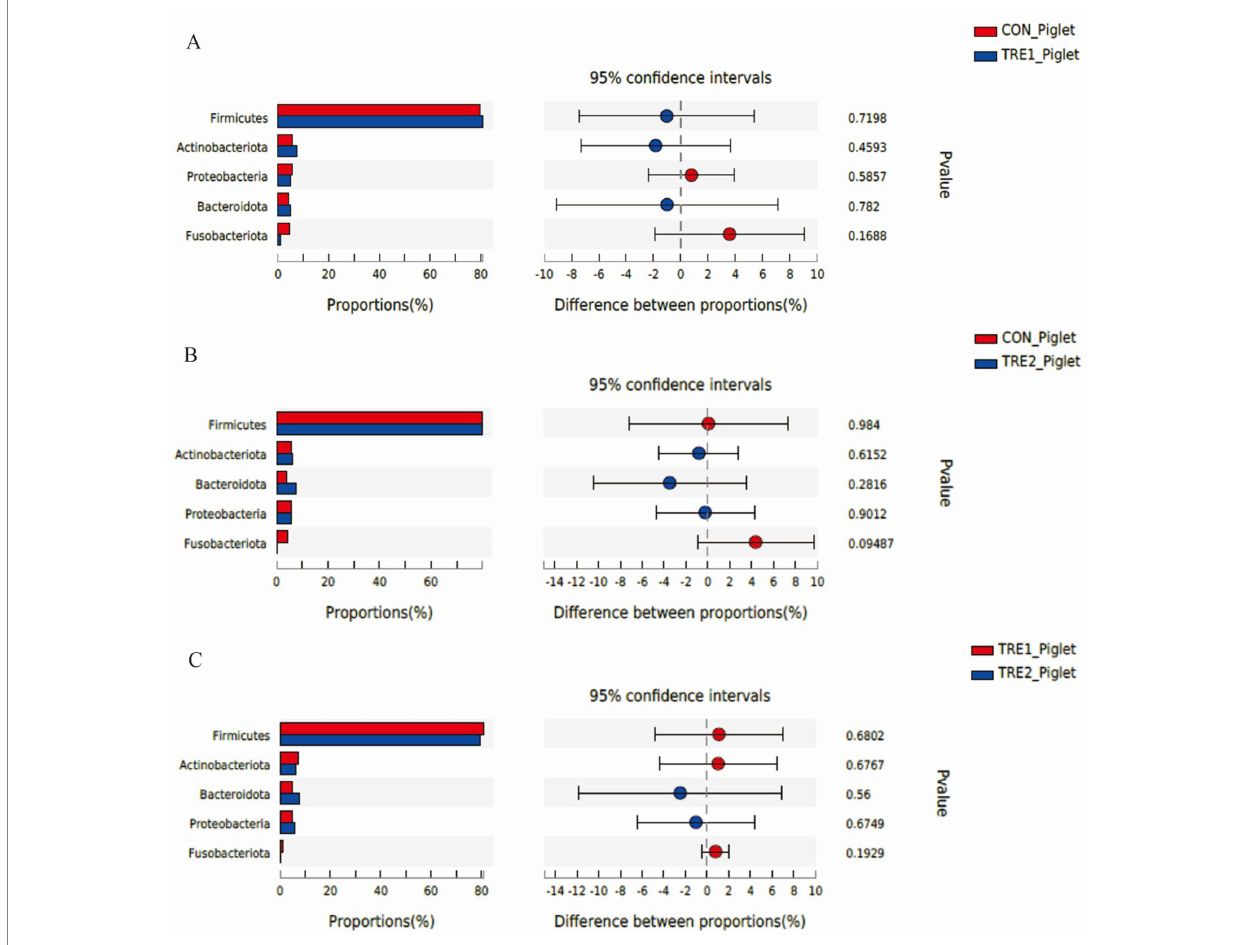
FIGURE 6 Differences in fecal microbiota of piglets at phylum level among different groups. (A) The difference in fecal microbiota for piglets between control group and TRE1 group. (B) The difference in fecal microbiota for piglets between control group and TRE2 group. (C) The difference in fecal microbiota for piglets between TRE1 and TRE2 groups. Piglets are regarded as the experimental units, N = 5 for each